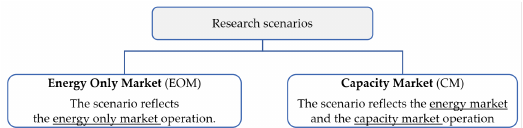
Figure 2. Research scenarios.